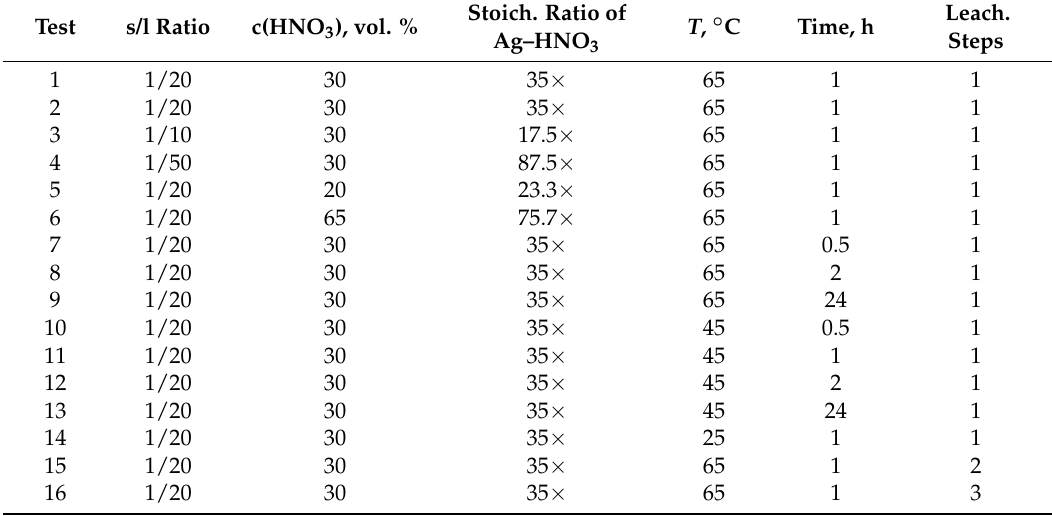
Table 2. Parameters of nitric acid leaching tests (parameter of investigation is set